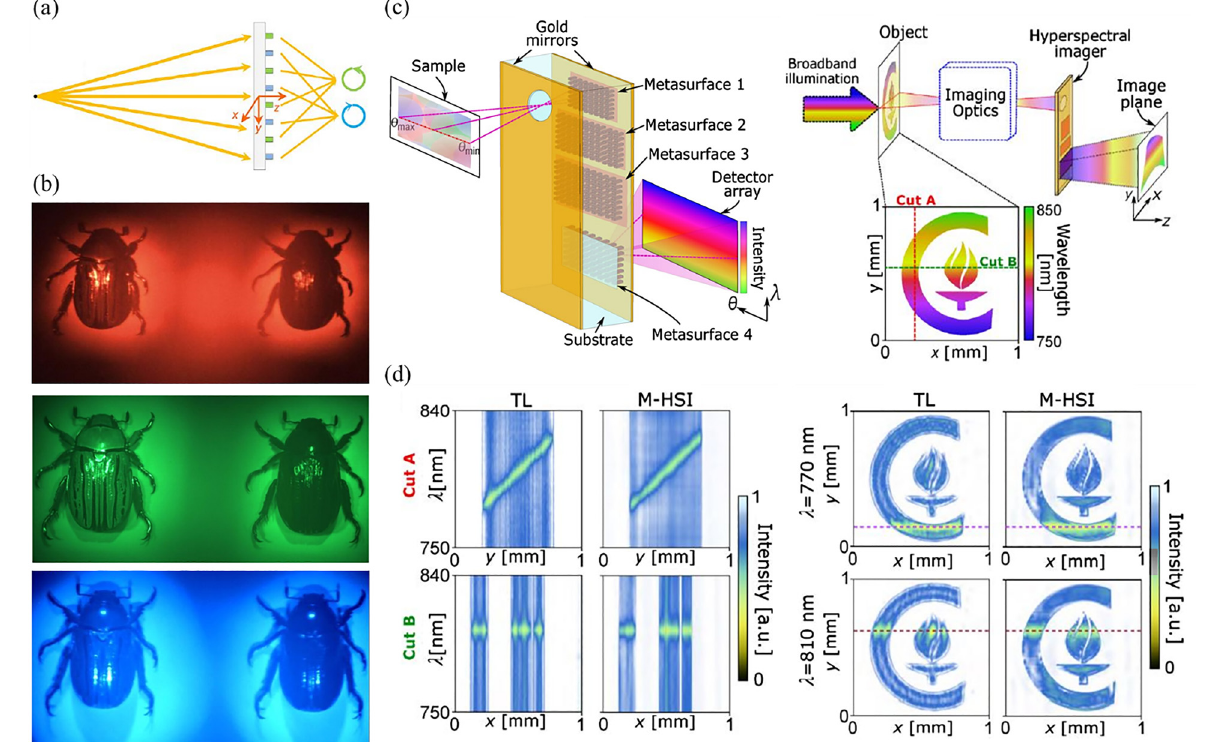
Figure 6: Metasurface-based lens and reflectors for spectral imaging. (a) Top panel: schematic illustration of the multispectral metalens imaging principle: the light from object with different circular polarizations is focused at different location by the multispectral chiral lens. (b) The beetle ( Chrysina gloriosa ) images formed by using red, green and blue LED illumination together with a band pass fi lter at each wavelength. (a) and (b) are adapted with permission from the study by Khorasaninejad et al. [70].Directlink:https://pubs.acs.org/doi/10.1021/acs.nanolett.6b01897.Furtherpermissionsrelatedtothematerialexcerptedshouldbedirected to the ACS. (c) Left panel: the schematic of the hyperspectral imaging system: the light from sample enters the system through the aperture at the top,thenisre fl ectedbetweenthemetasurfacesandgoldmirrors,andexitsthroughthetransmissivemetasurfaceatthebottom.Ondetectorarray, light with different incident angles is focused along the horizontal direction, and light with different colors is focused along the vertical direction. Right panel: the simpli fi ed schematic of the system for imaging the object. Inset shows the object of Caltech logo with mixed color, whose wavelength increases frombottom(750 nm) to top (850 nm). (d) Left panel: measured intensity pro fi le captured by photodetector (PD) across cut A andcutBbythemetasurfacehyperspectralimager(M-HSI).M-HSIimagingresultisbenchmarkedwiththeintensitypro fi leobtainedusingatunable laser (TL). Right panel: measured intensity at two wavelengths (770 and 810 nm) by M-HSI benchmarked with the one obtained using TL. (c) and (d)areadaptedwithpermissionfromthestudybyFaraji-Danaetal.[68].Directlink:https://pubs.acs.org/doi/full/10.1021/acsphotonics.9b00744. Further permissions related to the material excerpted should be directed to the